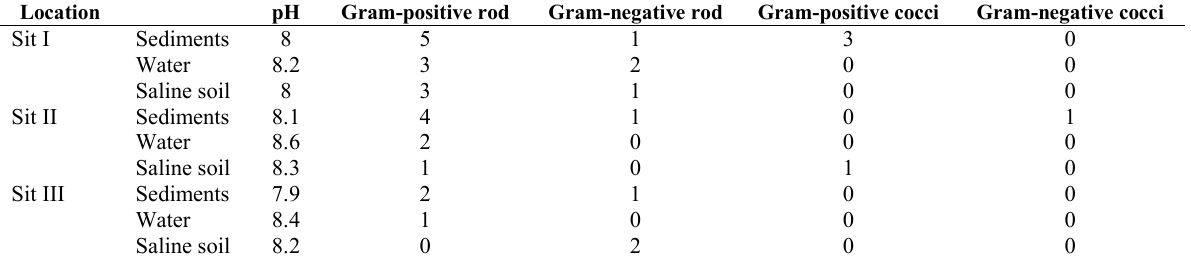
Table 1. Sampling sites, conditions, and some physiologic characteristics of halophilic isolates in Miankaleh Wetland.